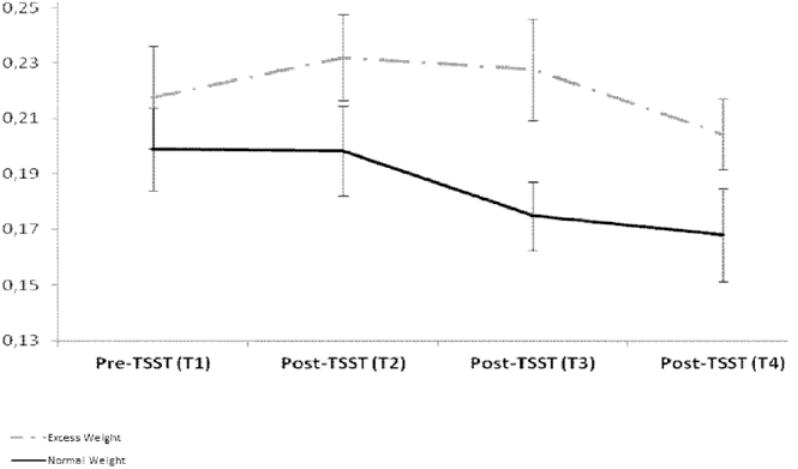
Fig 2. Cortisol levels ( μ g/dl units) in adolescents with excess weight and adolescents with normal weight before and after exposure to the Trier Social Stress Task (TSST). T1 represents cortisol levels before TSST; T2 represents cortisol levels immediately after TSST termination; T3 and T4 represents cortisol levels 10 and 20 minutes after TSST